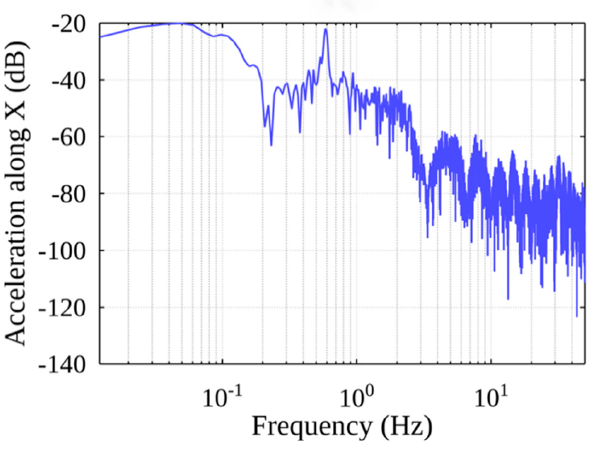
Figure 13. The generalized spectrum of acceleration along the X-axis of the container. The frequency spectrum between 3.5 Hz and 8 Hz captures the oscillations of the container when subjected to external influences, including the so-called safety events, i.e., the impacts of the container on the vertical cell guides. When a container impacts the guides, the direction of its movement changes (see Figure 14).